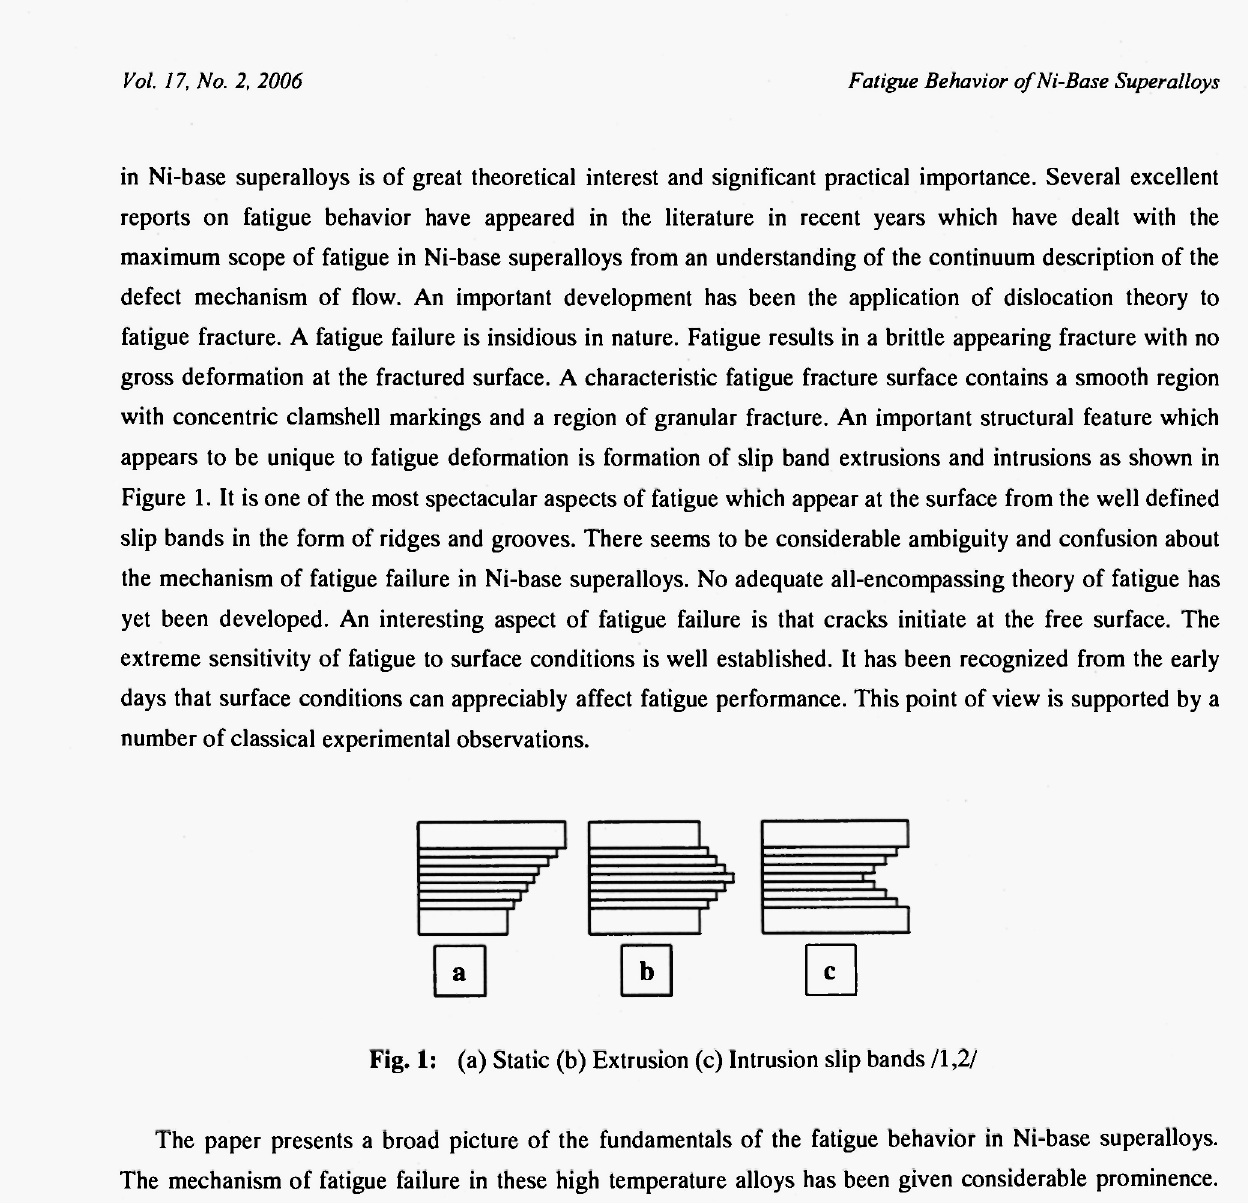
Fig. 1: (a) Static (b) Extrusion (c) Intrusion slip bands